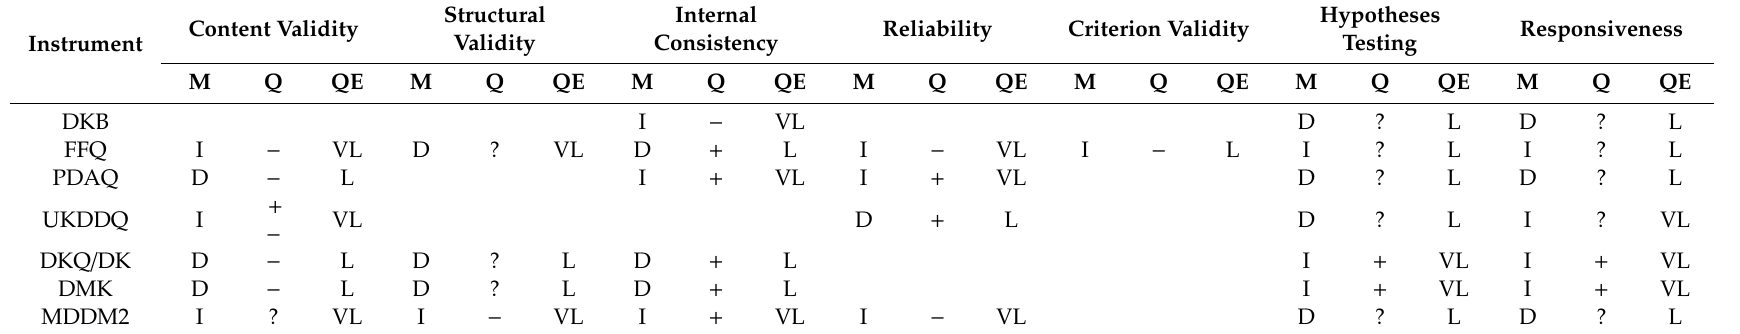
Table 4. Summary of findings per measurement property and